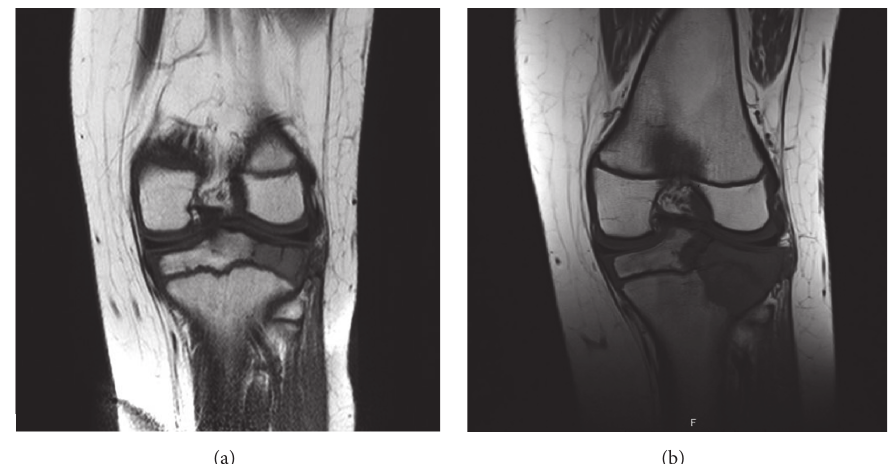
Figure 3: (a) MRI of a purely epiphyseal giant cell tumor in a proximal tibia. (b) 9 months later the lesion had progressed to include the metaphysis as well.